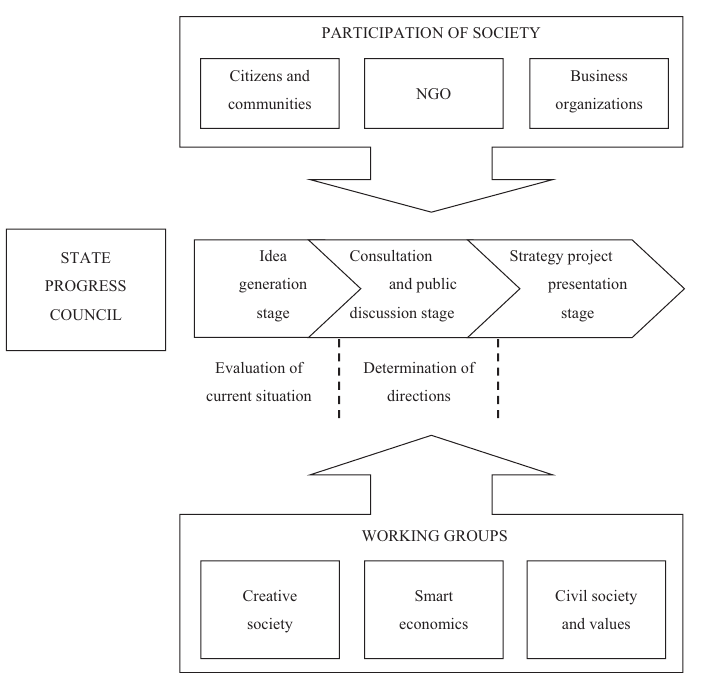
Figure 5. The empirical model of directions’ determination (during the preparation of the Lithuania’s Progress Strategy Lithuania 2030 ) of creative society policy (source: created by